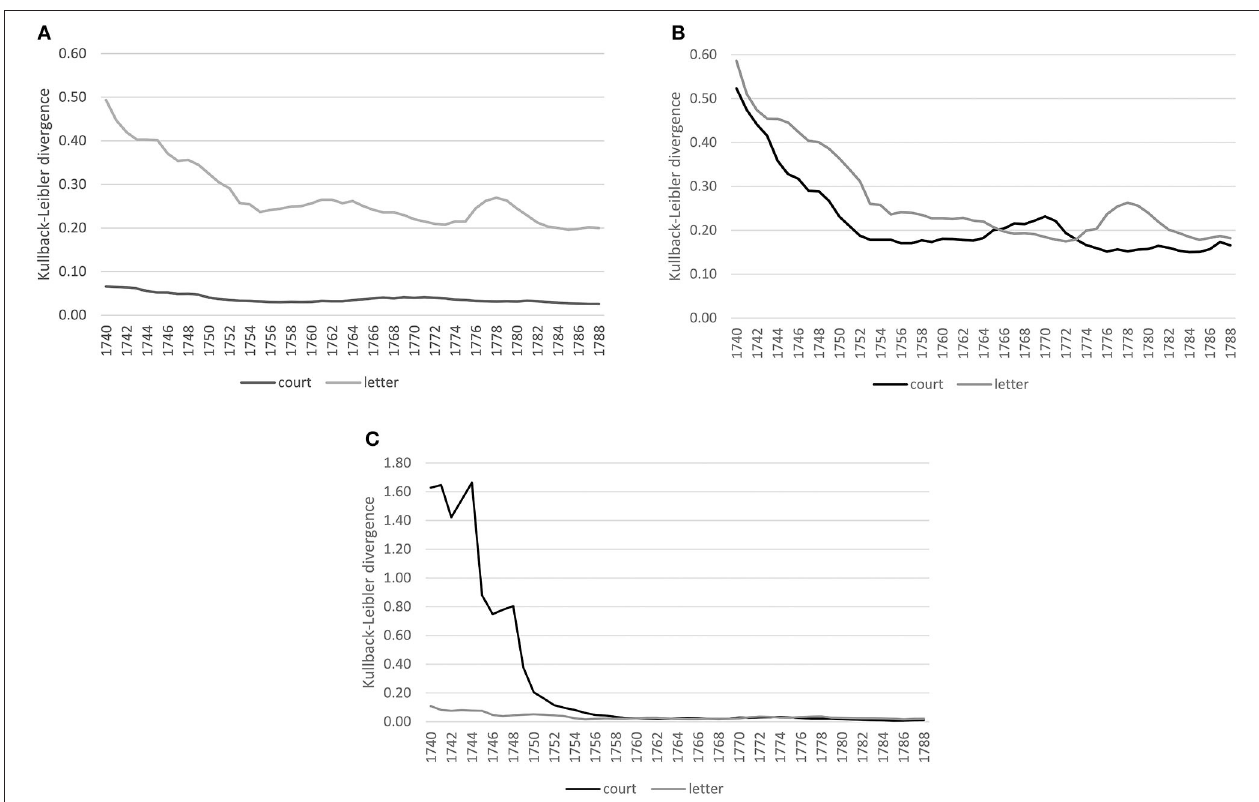
FIGURE 4 | Baseline models for the court and letter corpora across linguistic levels. (A) Lexis (word-unigram). (B) Grammar (part-of-speech trigrams). (C) Morphology